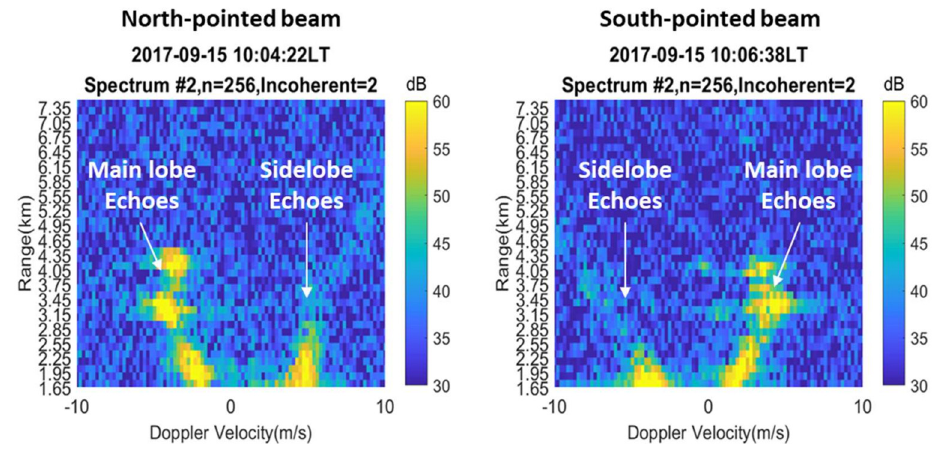
Figure 2. Doppler spectra observed by the north-pointed (left) and south-pointed oblique radar beams of the Chung-Li VHF radar, in which the spctral components of the radar returns received by the main lobe and side lobe are